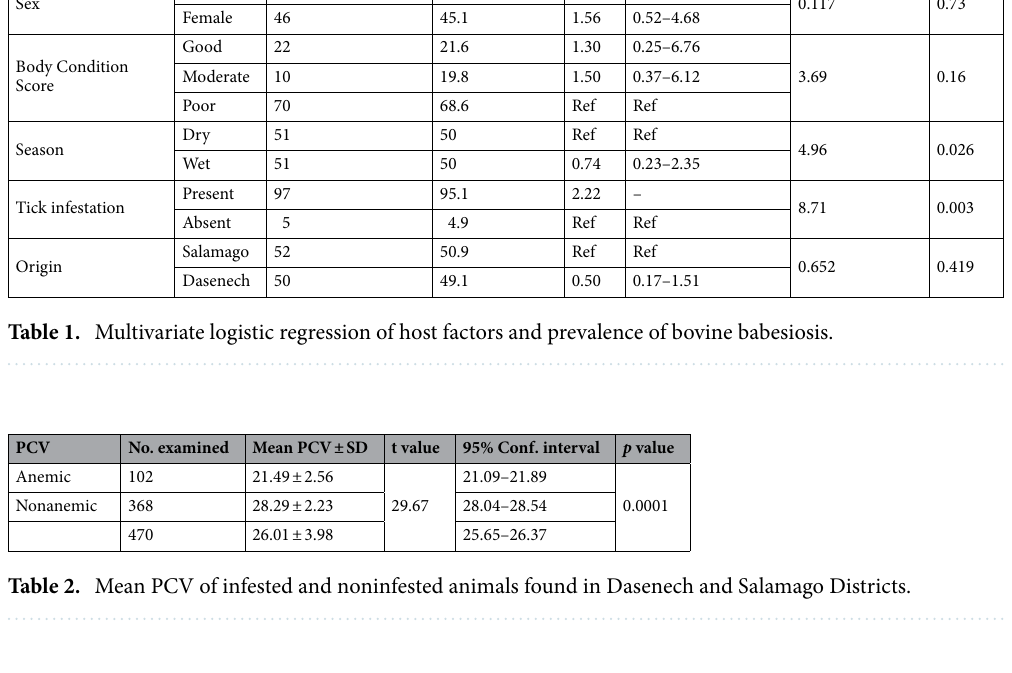
Risk factor Category